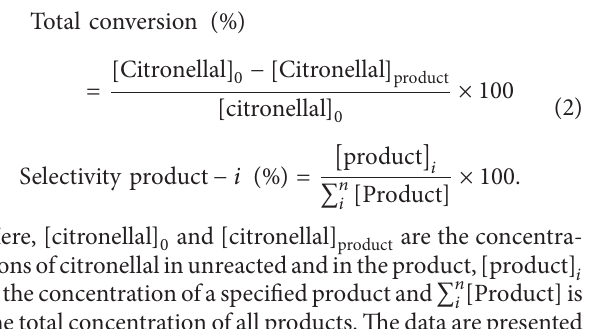
Table 4: Total conversion and selectivity on citronellal conversion over